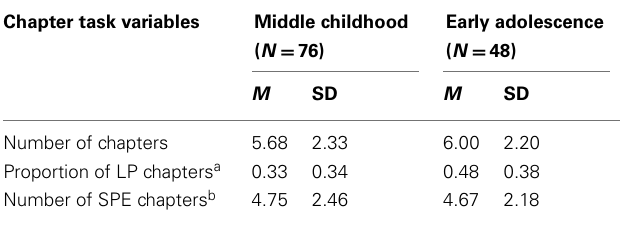
Table 1 | Number and types of life story chapters in middle childhood and early adolescence (Study